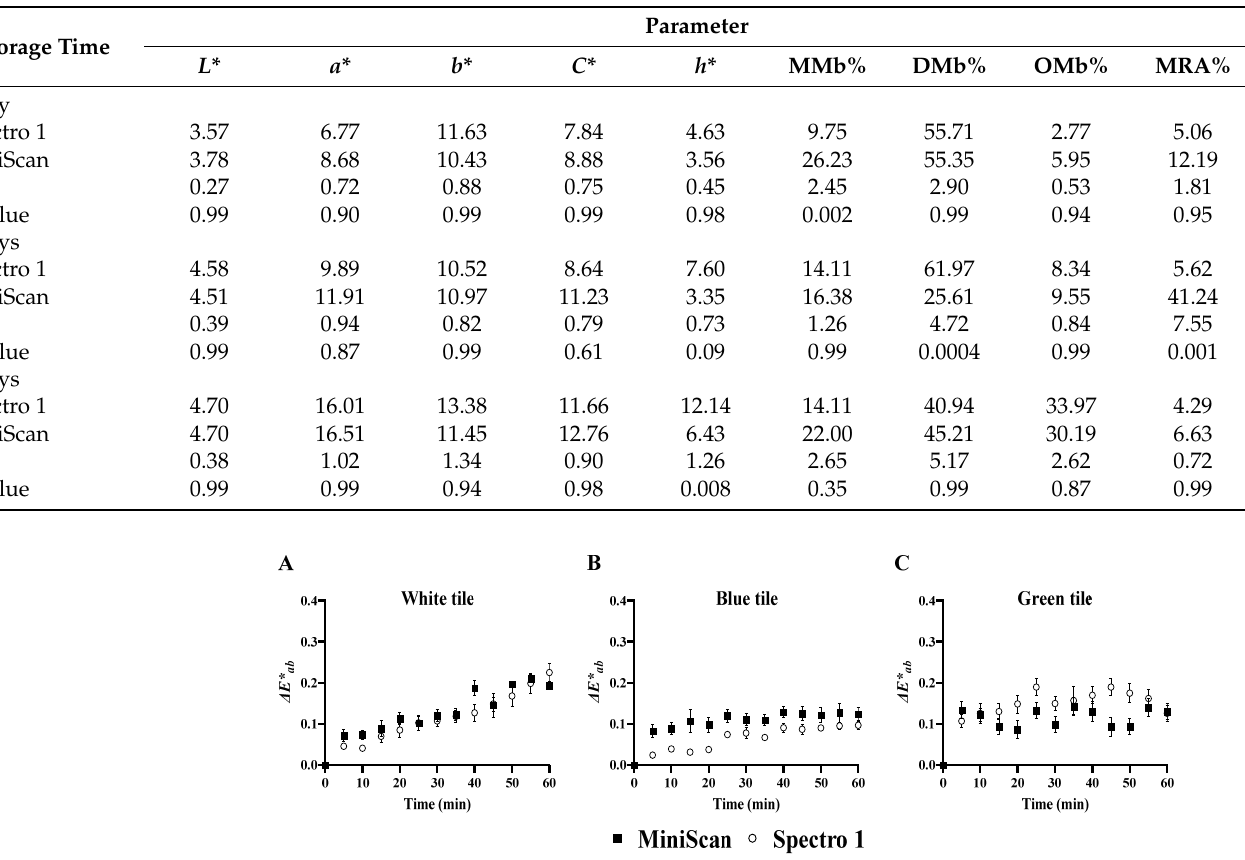
Table 1. Coefficient of variation (CV) for lightness ( L *), redness ( a *), yellowness ( b *), chroma ( C *), hue ( h *), metmyoglobin% (MMb%), deoxymyoglobin% (DMb%), oxymyoglobin% (OMb%), and metmyoglobin reducing ability% (MRA%) obtained from beef steaks at 0, 3, and 5 days of storage using Spectro 1 and MiniScan ( n = 12). Data are least-squares mean ± SE.